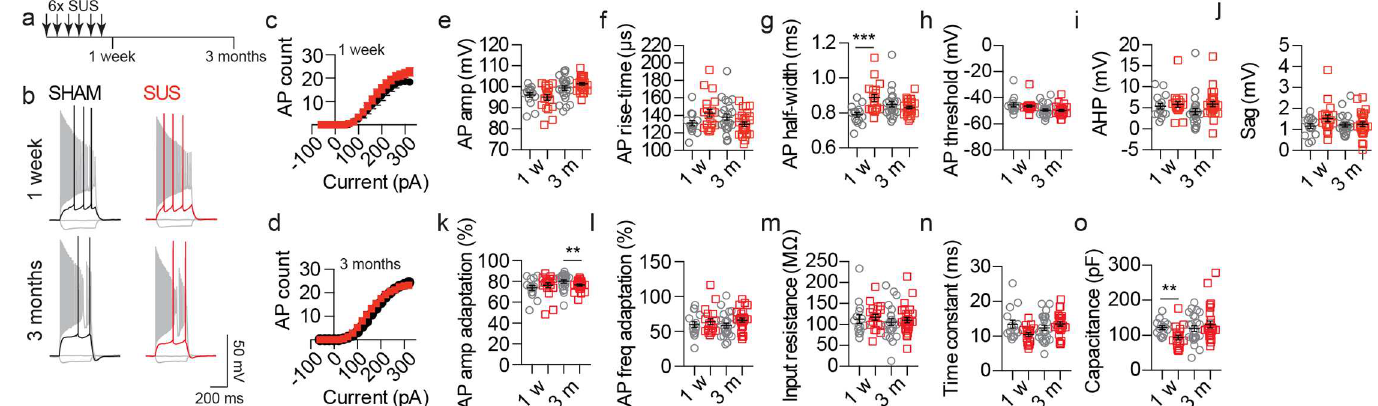
Fig 3. CA1 neuronal excitability is not impaired by multiple SUS treatments even after long time periods. (a) Schematic of the experimental design of multiple treatments. (b) Representative traces of APs generated by injectionof current steps (-60, 0, threshold and 320 pA). (c, d) Input-output relationships from sham- and SUS-treated neurons recorded( c ) 1 week (1 w, p = 0.39, SUS 182.5 ± 18.2 a.u., sham 155.7 ± 22.7 a.u.) or (d) 3 months (3 m, p = 0.62, SUS 204.8 ± 12 a.u., sham 193.4 ± 18.78 a.u.) after the end of treatment. Quantification of (e) AP amplitude(1 w, p = 0.88, SUS 95.1 ± 1.3 mV, sham 95.6 ± 1.3 mV; 3 m, p = 0.67, SUS 101.4 ± 0.68 mV, sham 100.1 ± 1.3 mV), (f) rise-time (1 w, p = 0.13, SUS 142.9 ± 4.5 μ s, sham 132.1 ± 3.6 μ s; 3 m, p = 0.23, SUS 130.2 ± 2.52 μ s, sham 137.2 ± 4.43 μ s), (g) half-width(1 w, p < 0.0001, SUS 0.89 ± 0.02 ms, sham 0.79 ± 0.02 ms; 3 m, p = 0.96, SUS 0.83 ± 0.008 ms, sham 0.84 ± 0.02 ms), (h) AP threshold (1 w, p = 0.63, SUS -46.2 ± 0.99 mV, sham -45.4 ± 1.58 mV; 3 m, p = 0.93, SUS -49.7 ± 0.75 mV, sham -49.4 ± 0.95 mV), (i) AHP (1 w, p = 0.34, SUS 5.8 ± 0.69 mV, sham 5.1 ± 0.69 mV; 3 m, p = 0.0011, SUS 5.9 ± 0.62 mV, sham 3.8 ± 0.94 mV), (j) sag (1 w, p = 0.10, SUS 1.5 ± 0.16 mV, sham 1.2 ± 0.13 mV; 3 m, p > 0.99, SUS 1.3 ± 0.11 mV, sham 1.3 ± 0.11 mV), (k) AP amplitudeadaptation(1 w, p = 0.21, SUS 76.3 ± 2.32%, sham 73.8 ± 2.33%; 3 m, p = 0.0081, SUS 76.6 ± 0.94%, sham 80.0 ± 1.47%), (l) AP frequency adaptation (1 w, p = 0.71, SUS 64.1 ± 4.23%, sham 60.0 ± 4.37%; 3 m, p = 0.08, SUS 66.3 ± 2.90%, sham 58.5 ± 3.52%), (m) input resistance (1 w, p = 0.28, SUS 117.5 ± 6.97 M Ω , sham 112.5 ± 10.69 M Ω ; 3 m, p = 0.58, SUS 110.7 ± 6.53 M Ω , sham 105.8 ± 8.07 M Ω ), (n) time constant (1 w, p = 0.08, SUS 10.5 ± 0.55 ms, sham 13.5 ± 1.16 ms; 3 m, p = 0.31, SUS 12.3 ± 0.62 ms, sham 12.4 ± 0.77 ms) and (o) capacitance (1 w, p = 0.0016, SUS 94.0 ± 6.88 pF, sham 122.2 ± 5.52 pF; 3 m, p = 0.49, SUS 131.3 ± 9.40 pF, sham 118.9 ± 2.82 pF). Data are presented as mean ± SEM and as individualdata points. ** p < 0.01 and *** p < 0.001. Sample size: one week time-point—SUS n = 19 neuronsand sham n = 15 neurons. 3 month time-point—SUS n = 27 neurons and sham n = 24 neurons.